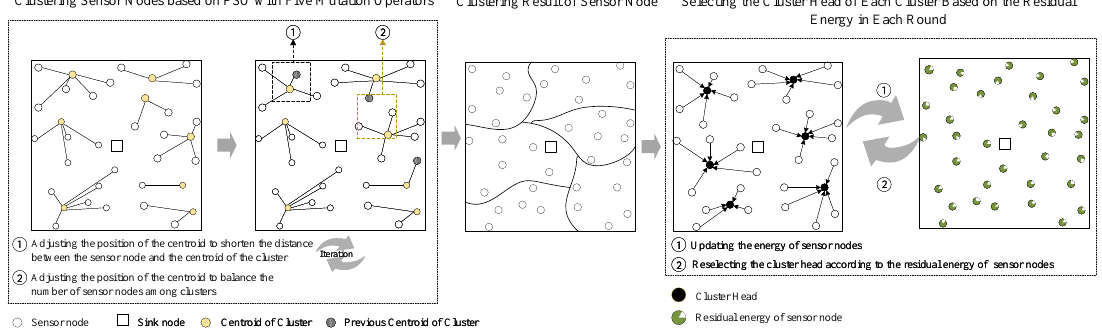
Figure 3. Main procedure of the proposed energy-balanced cluster-routing protocol